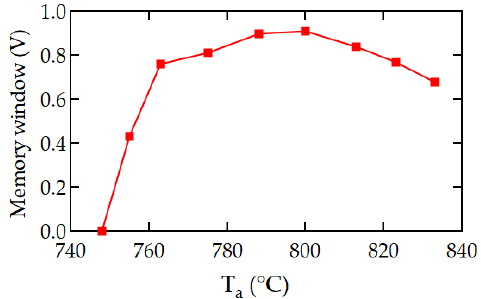
Figure 10. Memory windows vs. annealing temperature curve of C x S 1–x BT ( x = 0.1) FeFETs. Modified from [19].